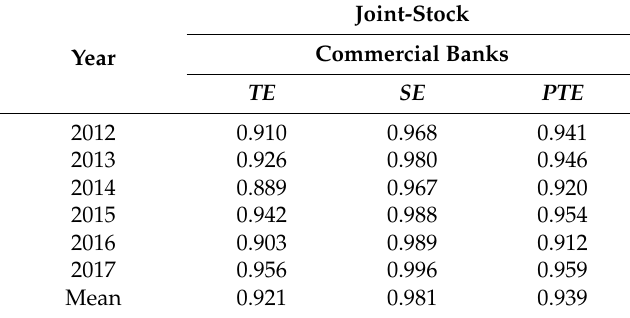
Table 9. The average efficiency of the joint-stock commercial banks